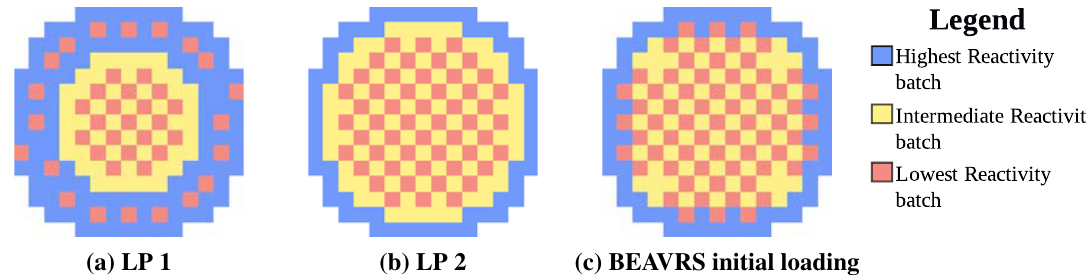
Figure 4: LP designs using SQA for a three fuel-type PWR compared with the initial core LP in the BEAVRS benchmark